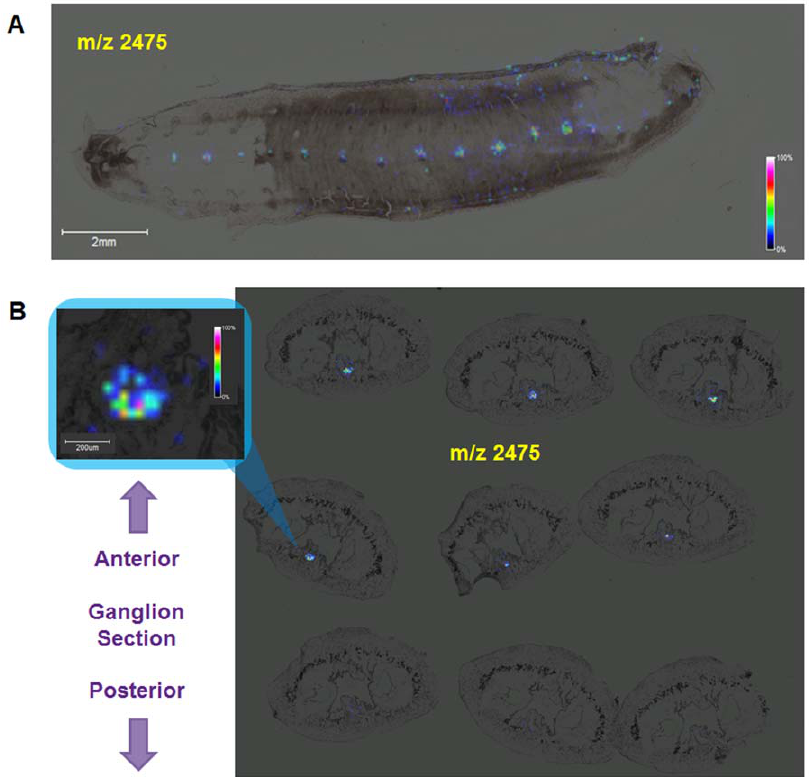
Figure 2. Expression of the ion at m/z 2475 in both embryonic and regenerating adult CNS segmental ganglia. A . Distribution of the m/ z 2475 ion in a 12-day old leech embryo determined by MALDI-MSI of a dorsally-opened, whole mounted specimen. The ion is found at the highest abundance in the segmental ganglia of the ventral nerve cord. Head on the left, tail on the right, dorsal midline on the upper and lower margins of the dissected embryo. B . Distribution of the m/z 2475 ion in sections of the regenerating adult ganglion analyzed in Figure 1. The insert shows a magnified image of the data for section 4, with the abundance of the ion color coded according to the color bar at right. The peak corresponding to this ion is absent in a control adult (Figure S1), indicating a strong up-regulation of expression following injury.